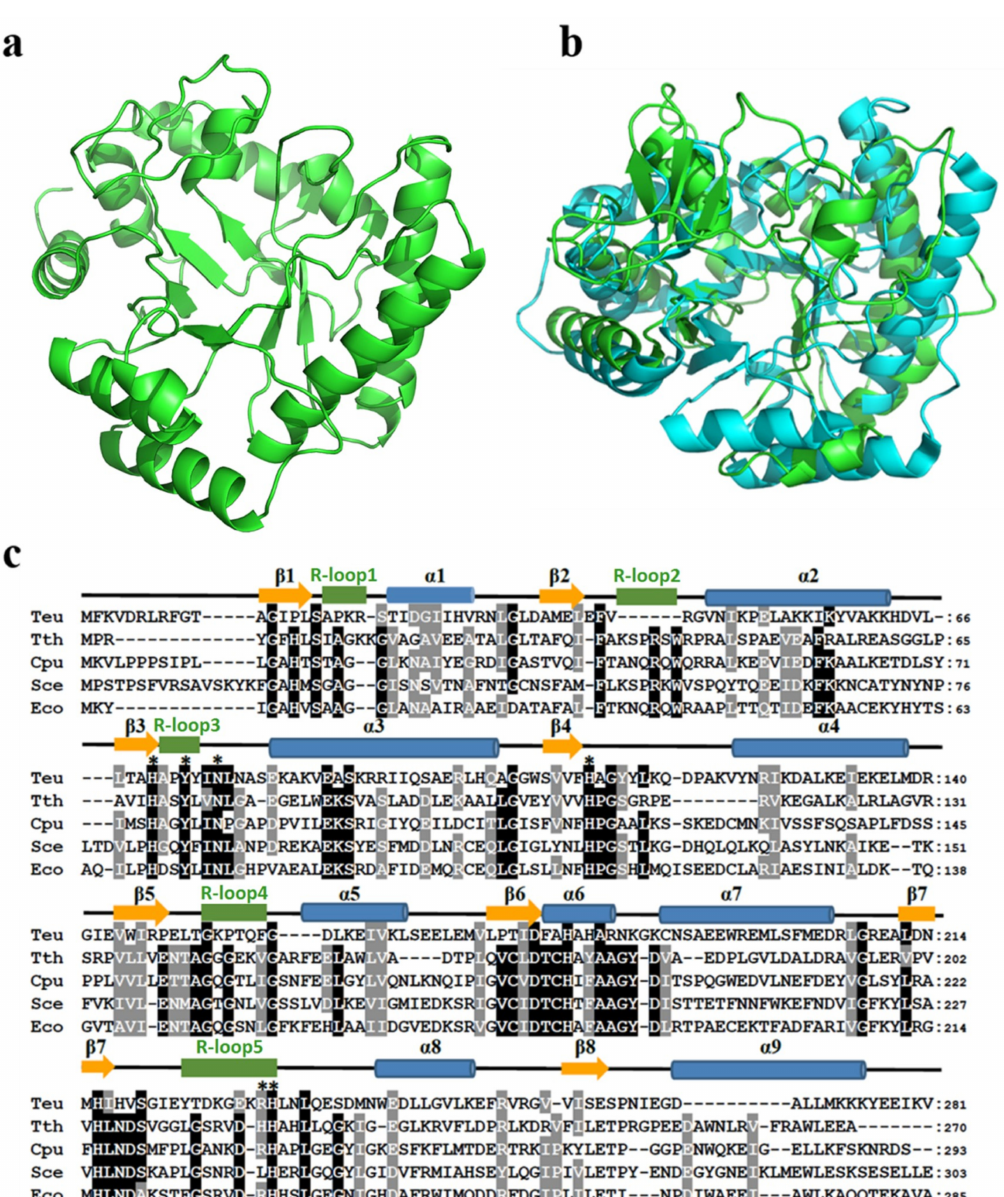
Figure 9. Homology model of TeuendoIV and multi-alignment of EndoIVs. ( a ) Modeled structure of TeuendoIV. ( b ) Superimposition of TeuendoIV (green) and EcoendoIV (cyan). ( c ) Multiple sequence alignment of EndoIVs. The EndoIVs are from T. eurythermalis , T. thermophilus (PDB ID: 3AAM), Chlamydophila pneumoniae , S. cerevisiae and E. coli (PDB ID: 1QTW). The secondary structures of EcoendoIV are shown at the top of sequences. Cylinders indicate α -helices, arrows indicate β -strands, and five green rectangles indicate DNA-binding recognition loops 1–5. Identical and similar residues are shaded in black and gray, respectively. The mutated residues are marked by